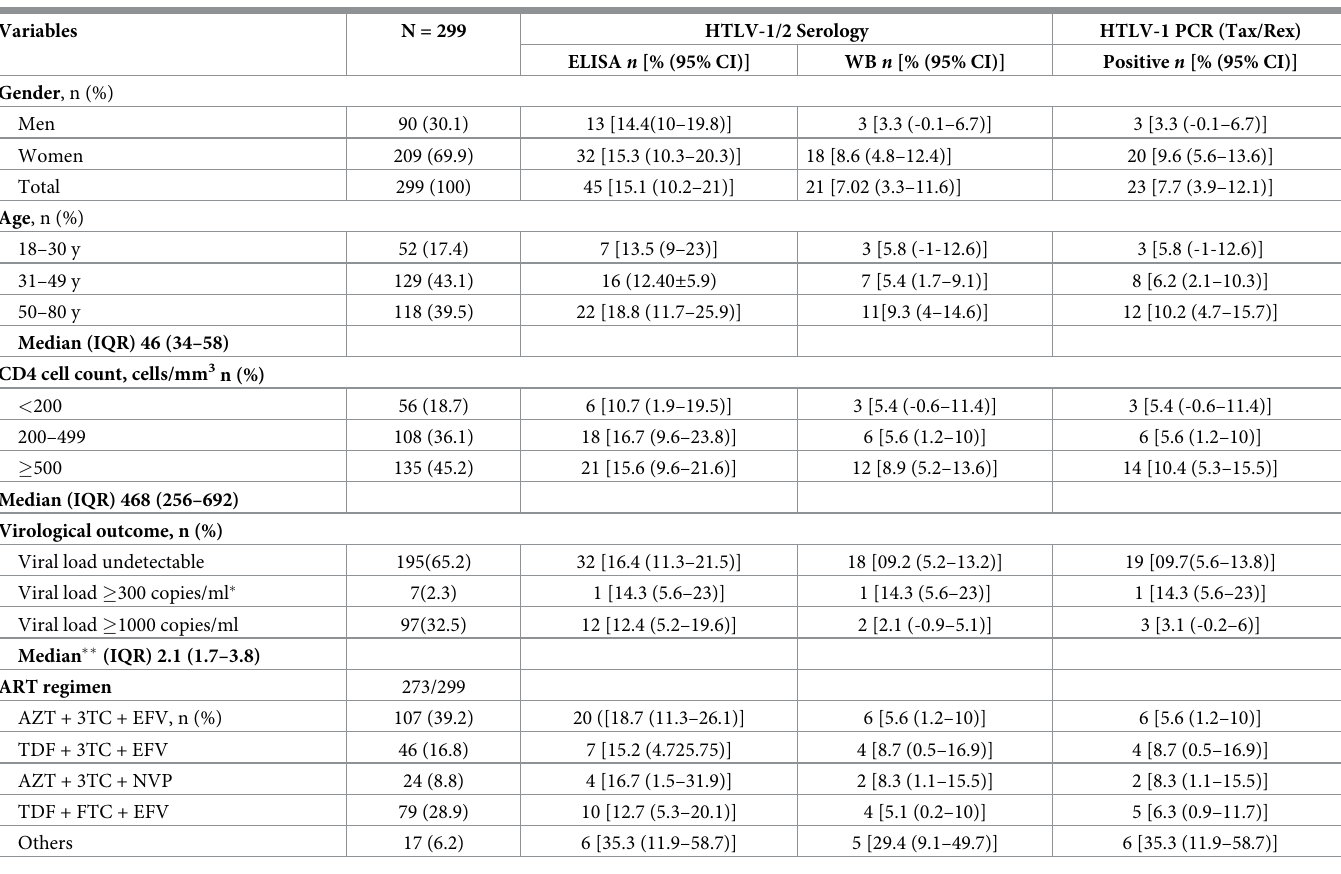
Table 1. Patient characteristics associated with HTLV-1/HIV-1 coinfection status according to serology and molecular